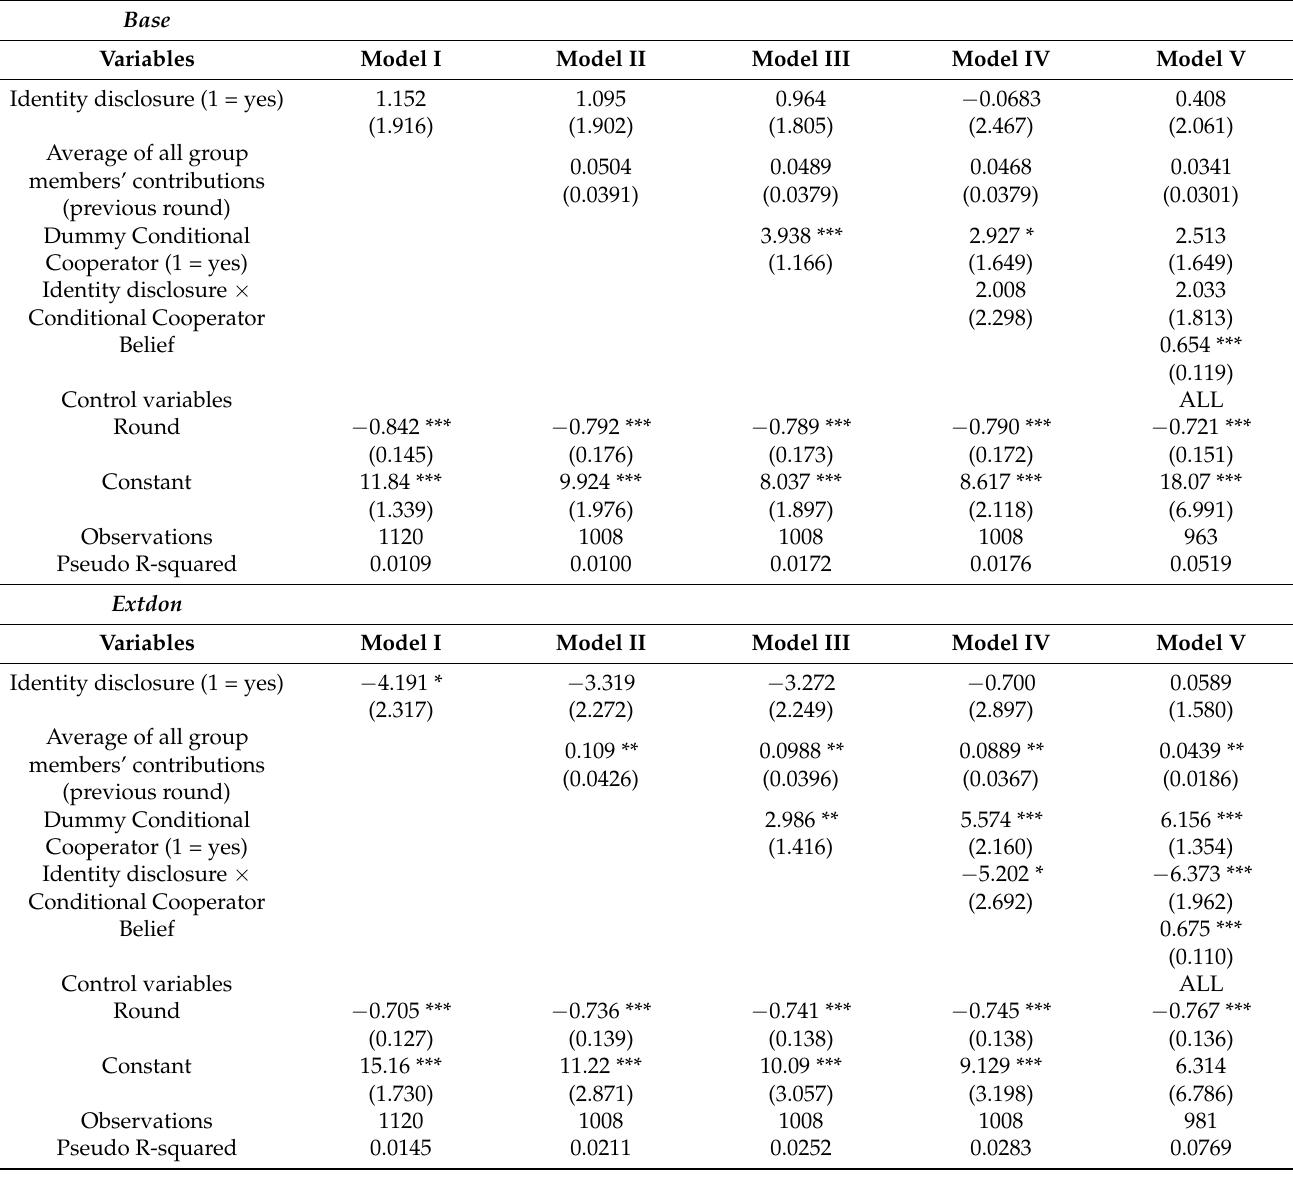
Table 3. Tobit regression on individual